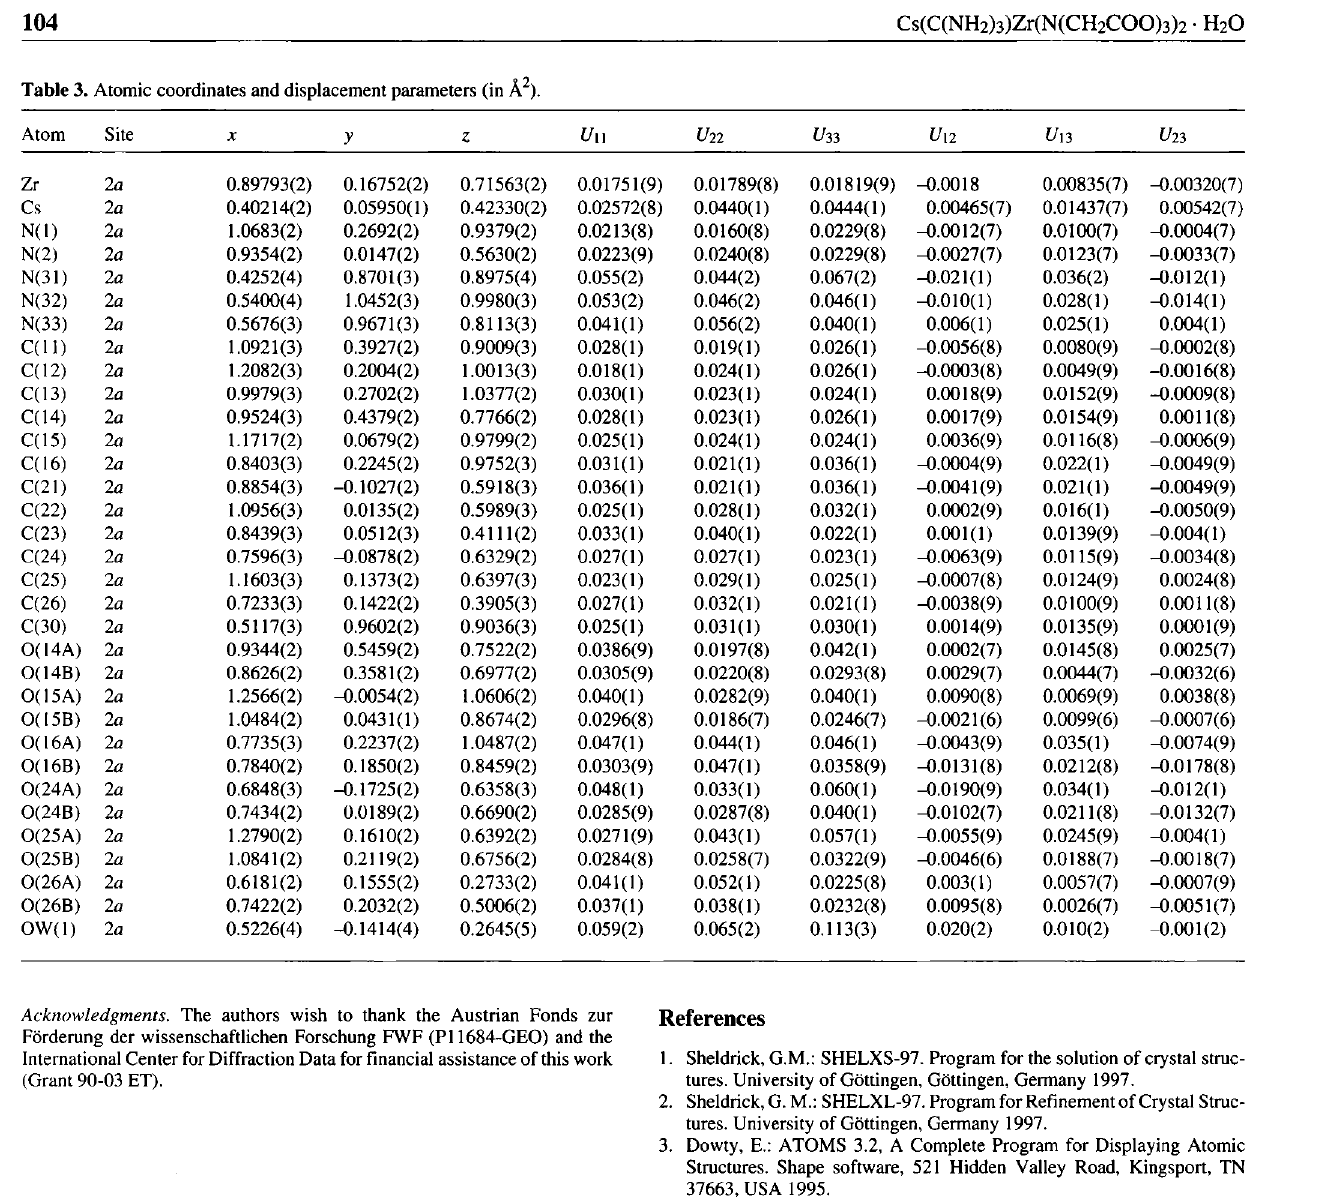
Table 3. Atomic coordinates and displacement parameters (in Ä 2